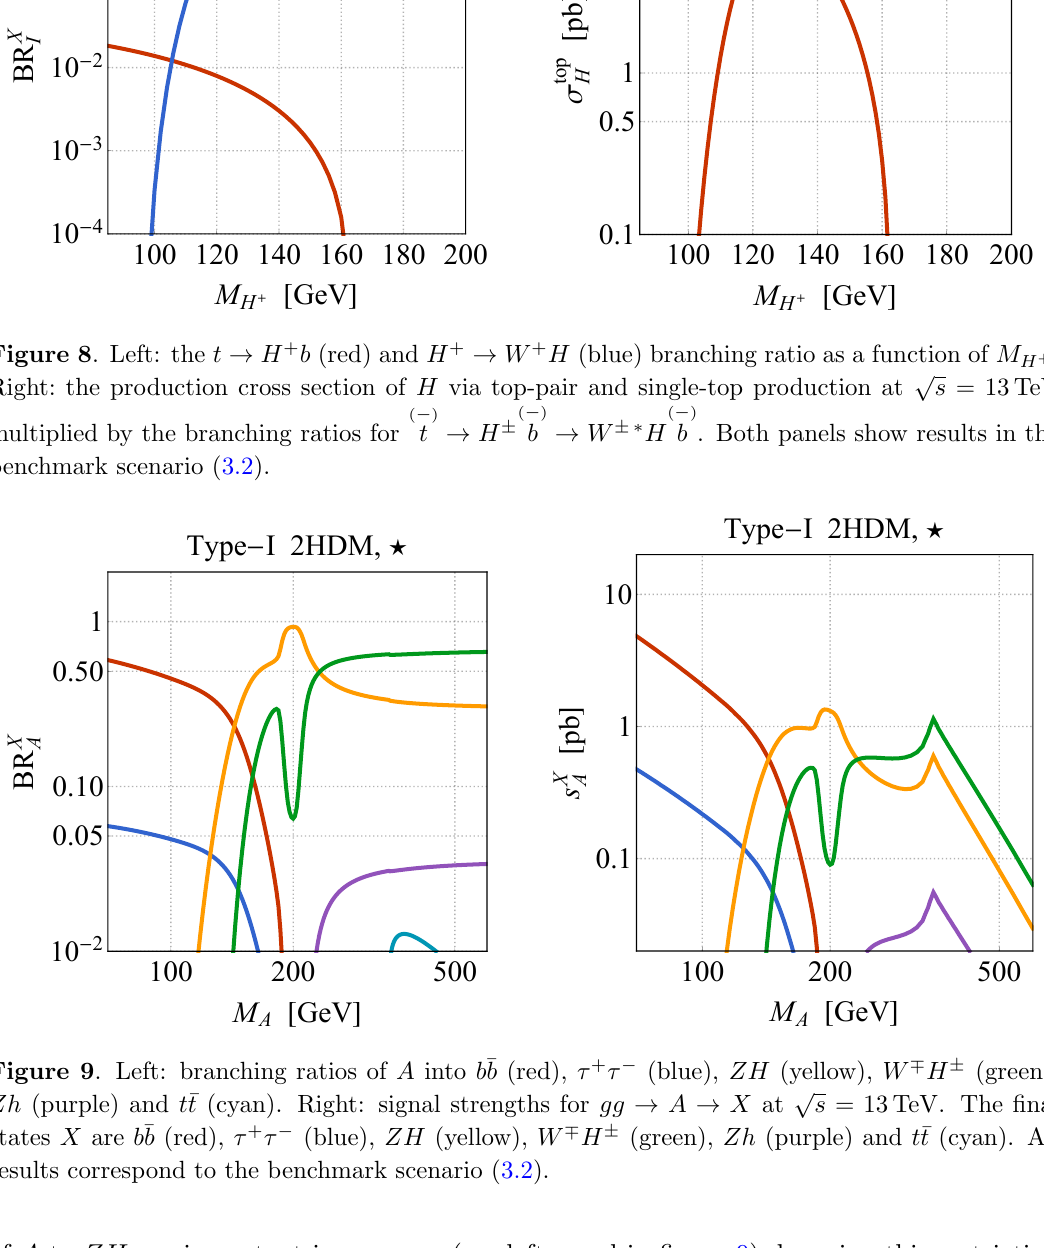
(cid:0) (blue), ZH (yellow), W (cid:7) H (cid:6) (green), p s = 13 TeV. The (cid:12)nal